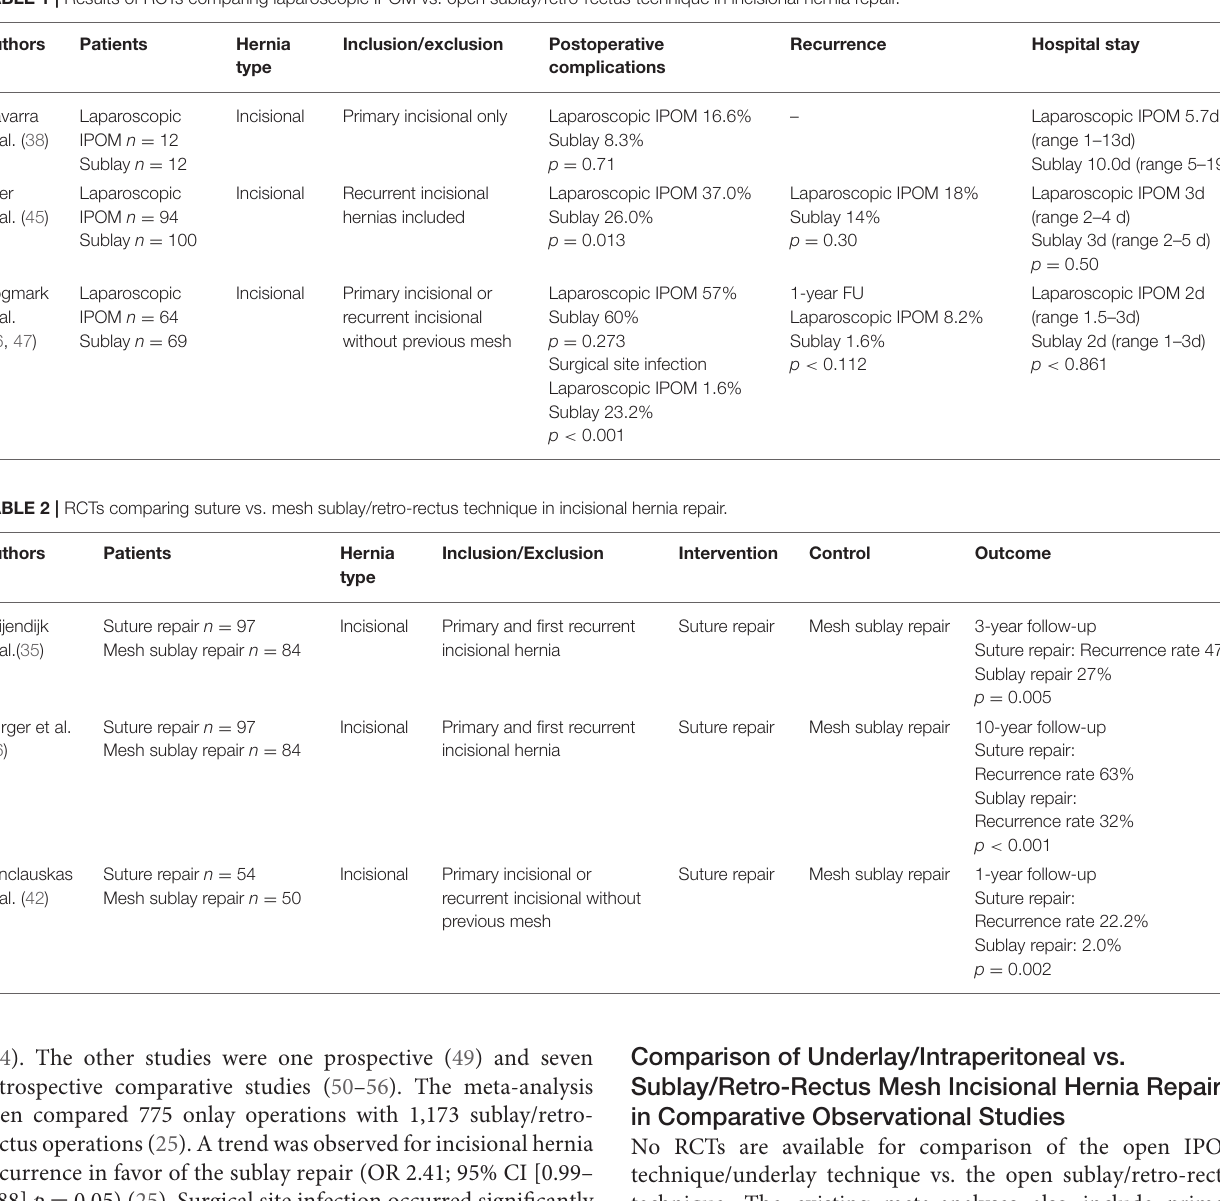
TABLE 1 | Results of RCTs comparing laparoscopic IPOM vs. open sublay/retro-rectus technique in incisional hernia repair.